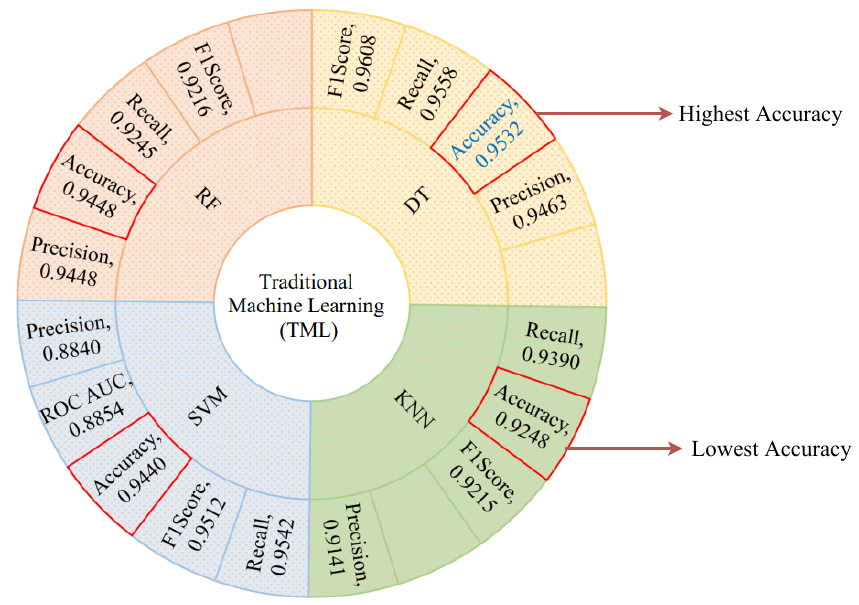
Figure 9. TML algorithms’ performance metrics